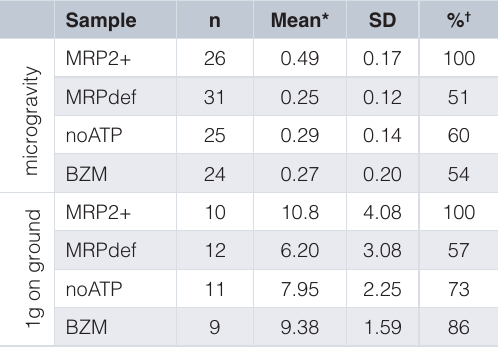
Table 1. Detected E17 β G signal in microgravity and 1g conditions. Sample